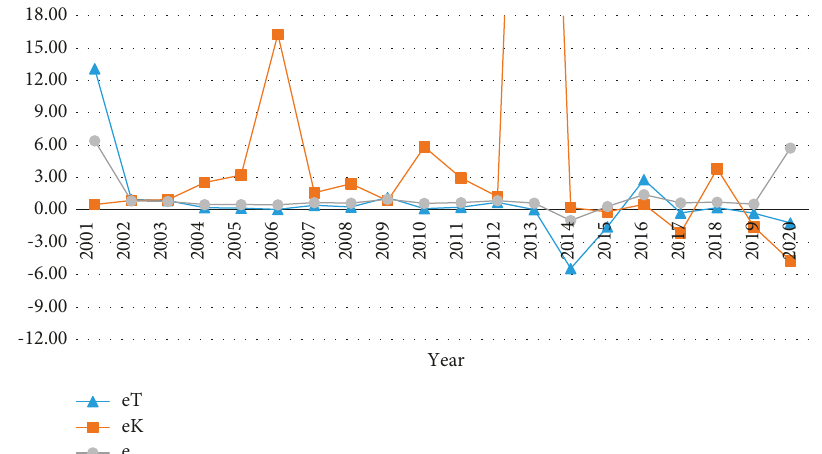
Figure 25: Relationship between carbon emission decoupling index of the mining industry and intermediate variables. Note. In Figure 25, the value of e K in 2013 is 87.96, because it is too large than other values, so it is not shown in the